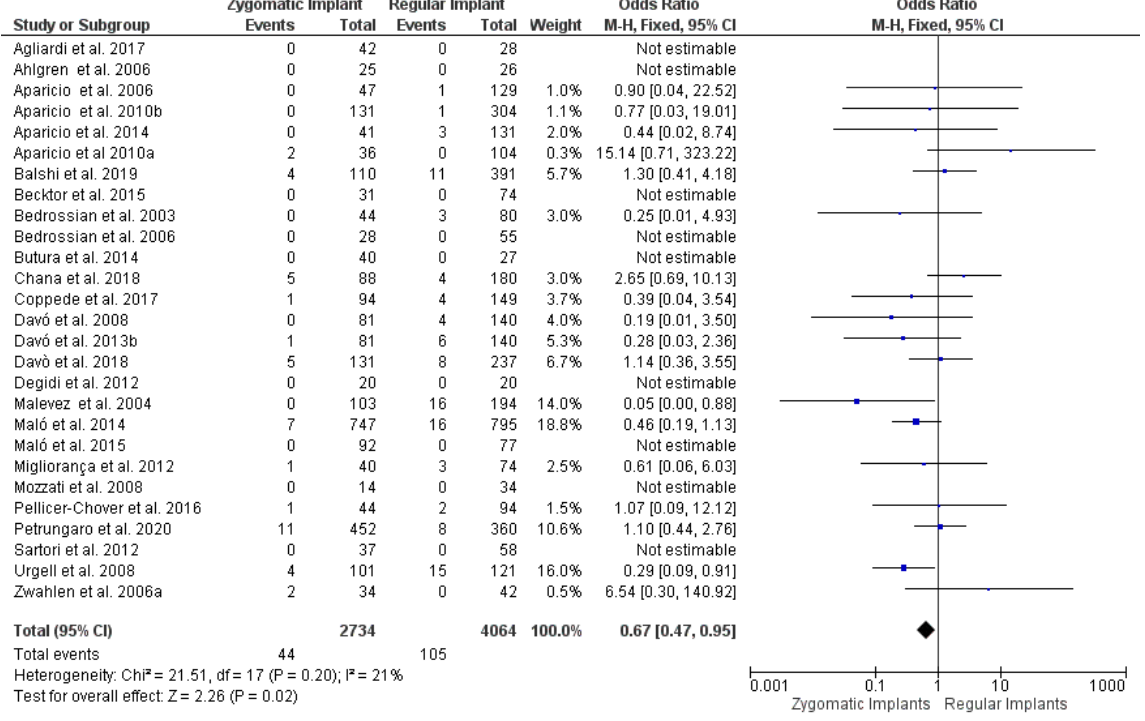
Figure 4. Forest plot of comparison between the zygomatic and regular implant survival rate.